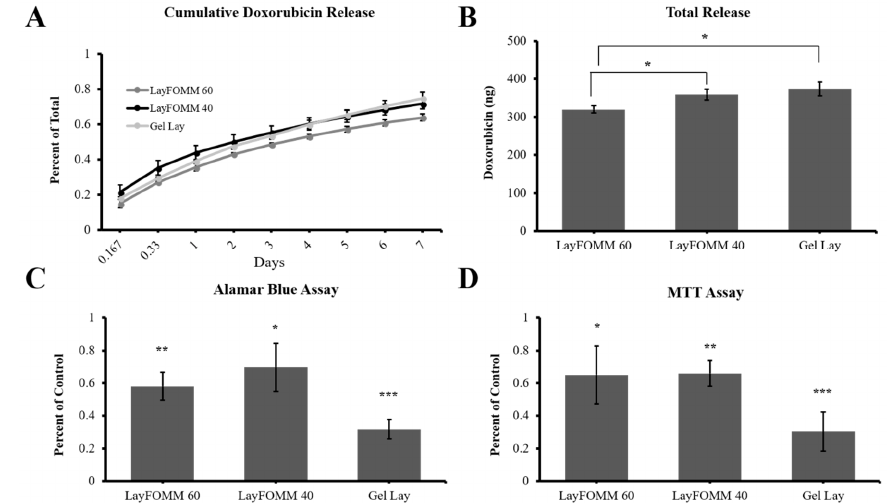
Figure 5. 3D printed scaffolds for DOX release. ( A ) 3D printed polymer discs loaded with 500 ng of DOX can sustainably release more than 50% of loaded drug into solution by day 7. ( B ) Total